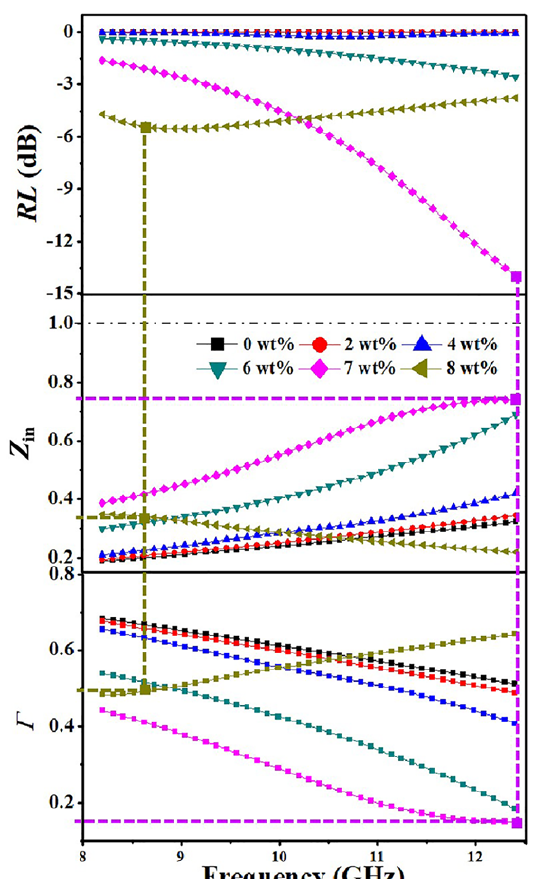
Fig. 17 Reflection loss, incident impedance, and reflection coefficient of SG/AlN composites with different SG